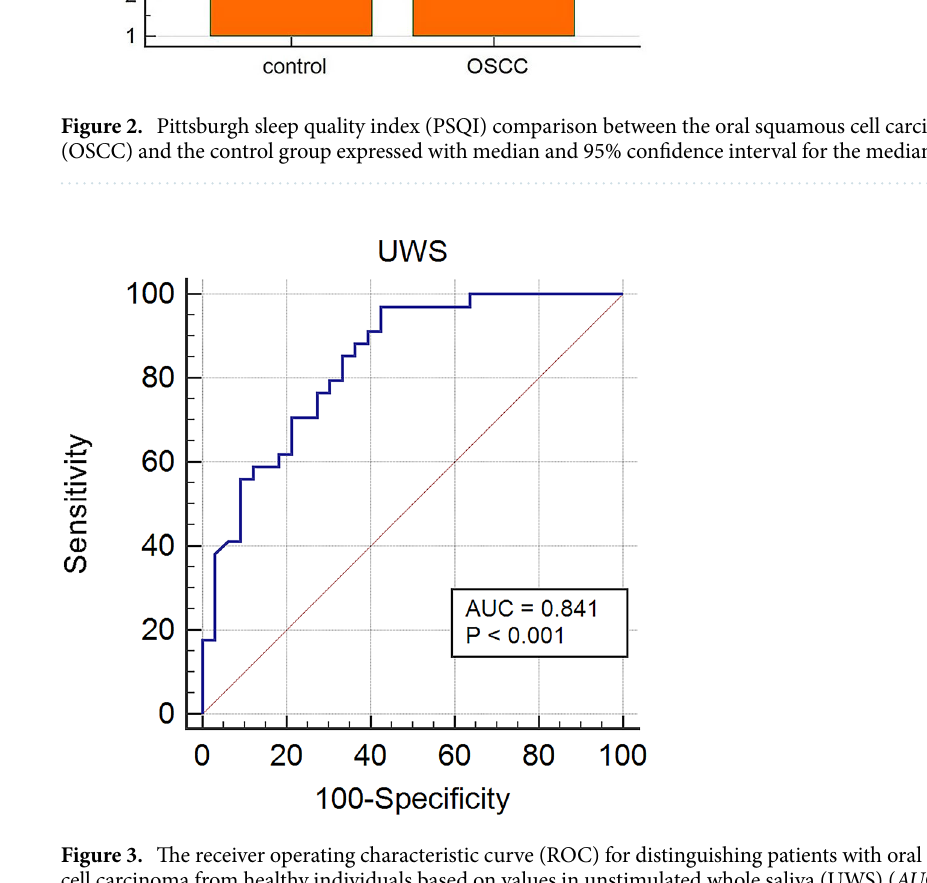
(Fig. 3). ROC analysis for distinguishing patients with OSCC from healthy individuals based on values in SWS is presented in Supplement 4. ROC analyses for distinguishing patients with T1N0M0 and T2N0M0 OSCC from healthy individuals by MLT levels in UWS are presented in the Supplement 5–8. Comparison of OSCC patients and the control group determined by the cut off values of MLT levels in UWS (Fig. 3) and SWS (Supplement 4) is presented in Supplement 9 and 10, and found statistically significant (Fisher exact test, P < 0.001 and P < 0.001 respectively).